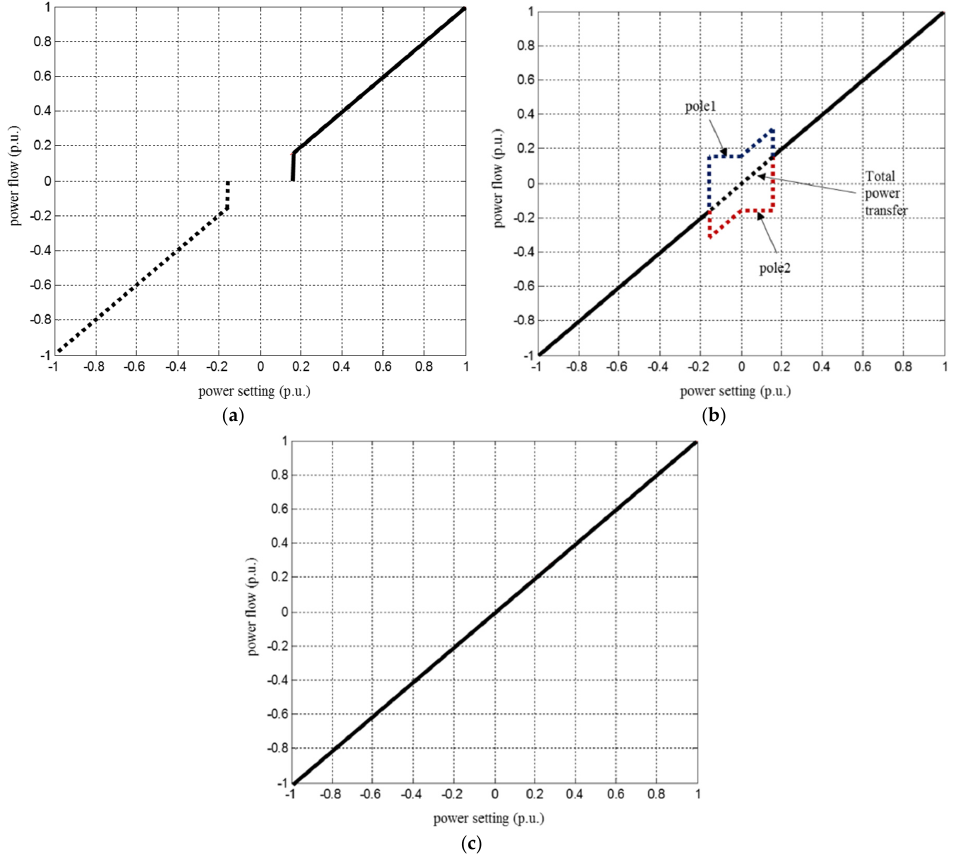
Figure 3. Power flow versus power setting depends on: ( a ) unidirectional line commutated converter (LCC) high-voltage direct current (HVDC); ( b ) bidirectional LCC HVDC; and ( c ) voltage-source converter (VSC) HVDC.